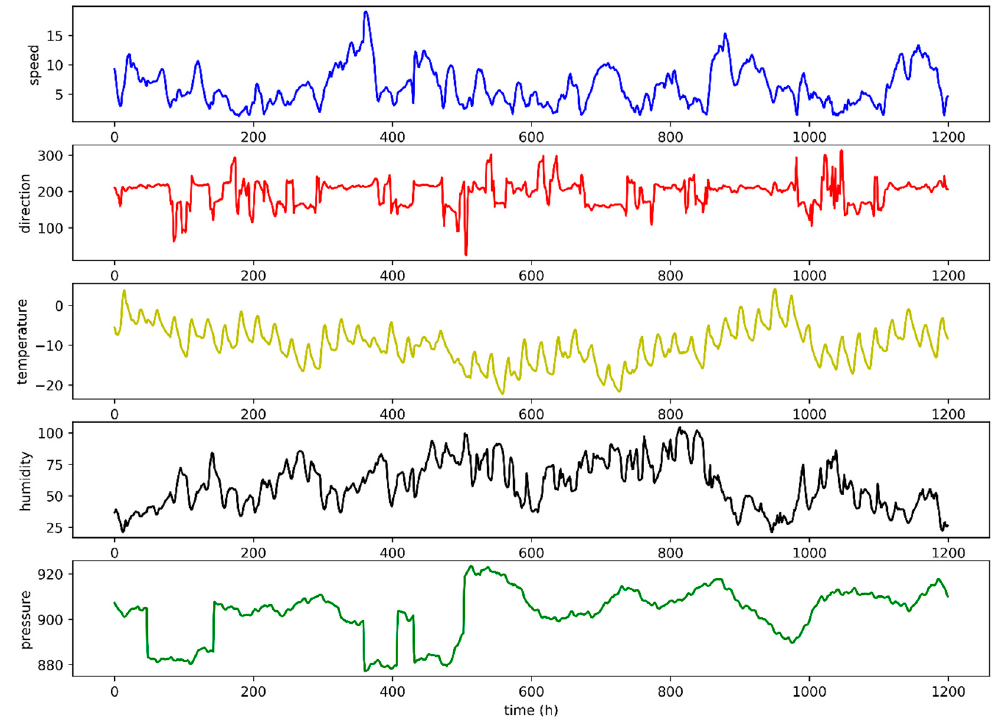
Figure 4. Line chart of different weather features .